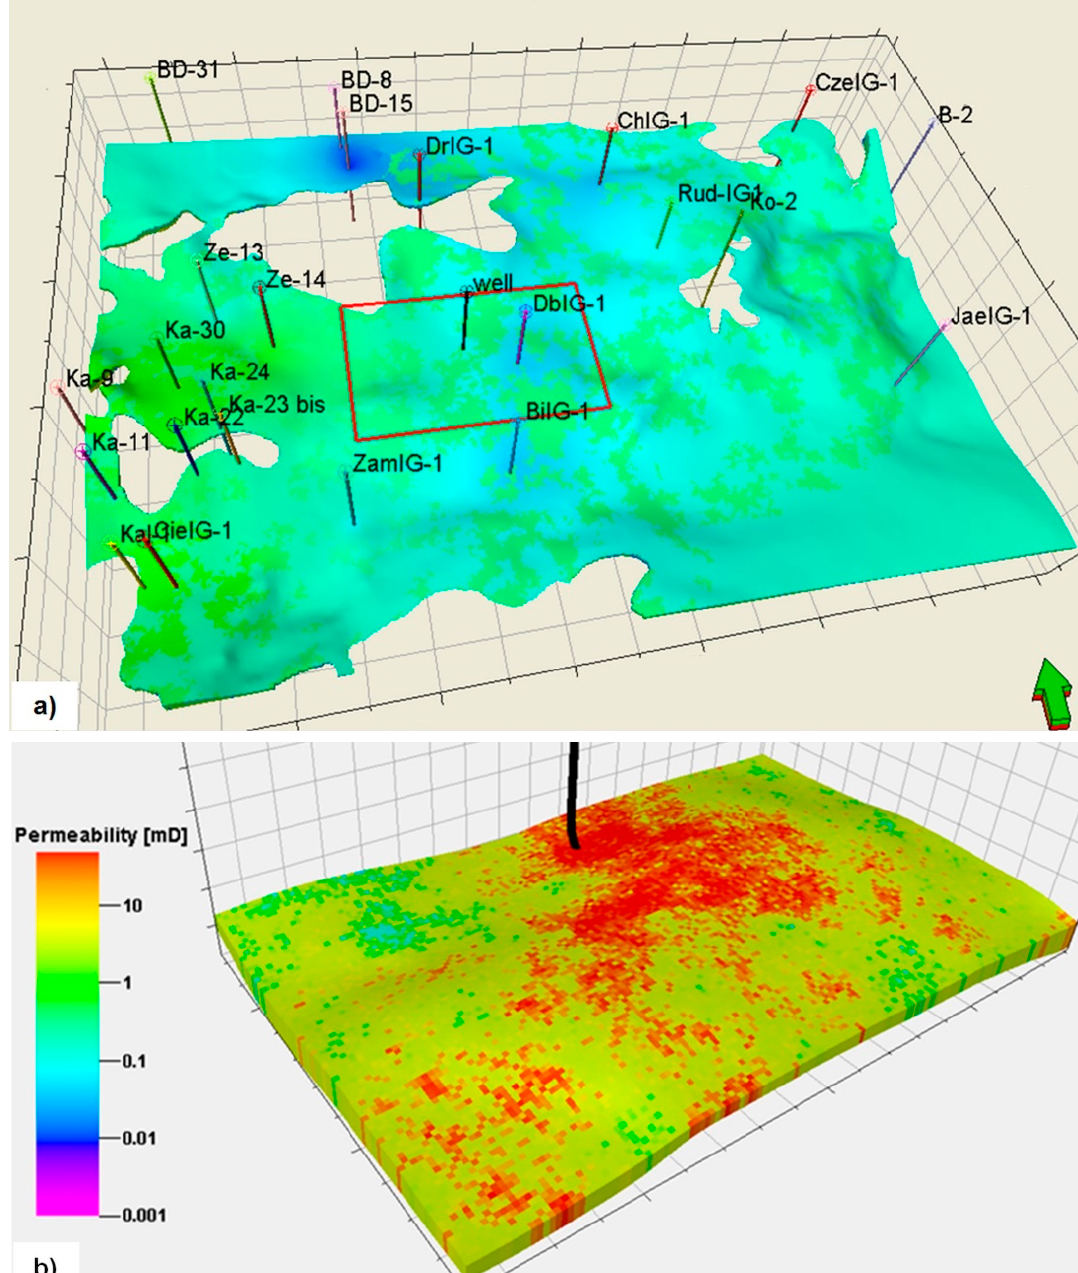
Figure 5. Static model within the D ę bowiec formation ( a ) together with a separated local model (permeability model) ( b ) for the purpose of reservoir simulation.